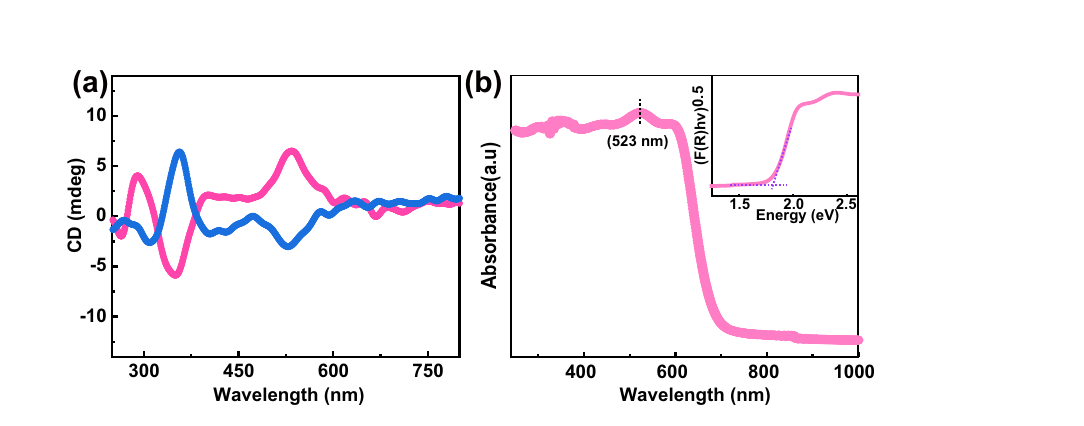
Fig. 3 | Optical characterizations of ABI. a Circular dichroism spectra of ABI crystals by using integrating sphereto detectthe diffuse re fl ectance. b Absorption